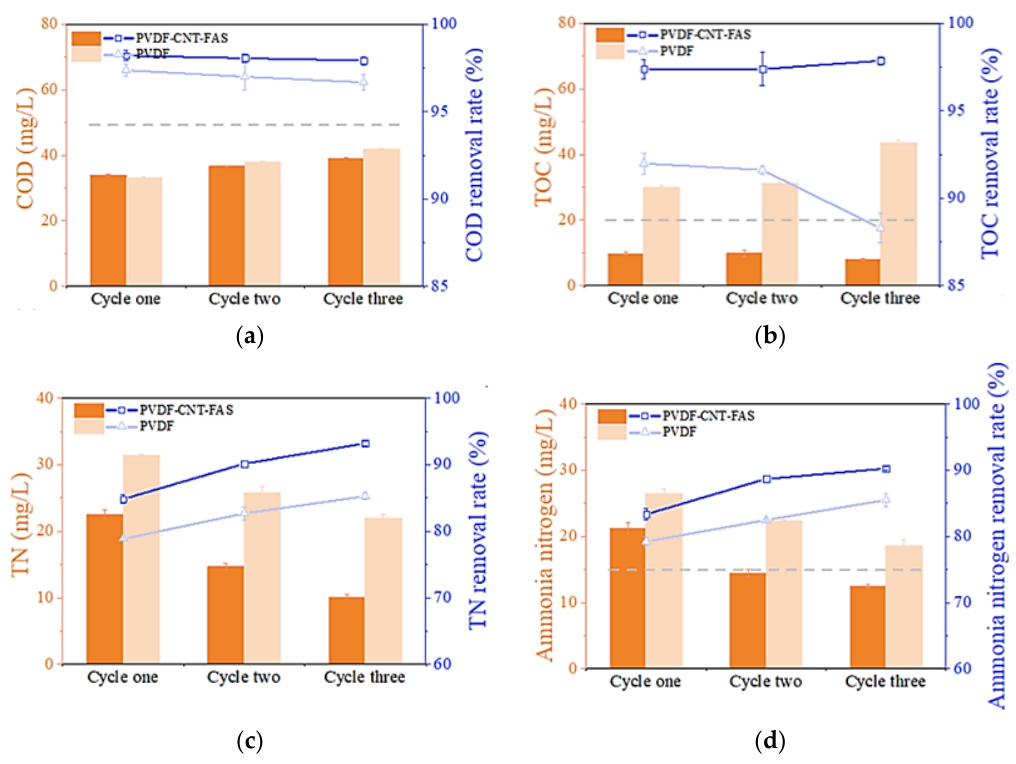
Figure 3. Permeate water quality at the end of each cycle in terms of the ( a ) COD, ( b ) TOC, ( c ) TN, and ( d ) ammonia. The dashed line denotes the corresponding limit value for each parameter according to the local standard (GB8978-2006).